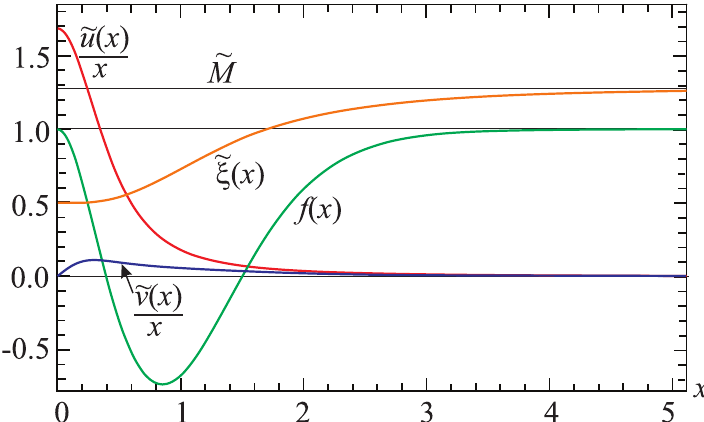
Figure 1. The graphs of the functions ˜ v ( x ) , ˜ u ( x ) , f ( x ) , and ˜ ξ ( x ) of the solution describing the spinball-plus-quantum-monopole system at ˜ λ = 0.1, ˜ Λ = 1/9, ˜ m q = 1, ˜ E = 0.8, m = 3, ˜ g = 1, ˜ ξ = 0.5, and f = − 20. The corresponding eigenvalues are ˜ µ ≈ 2.6727842881, ˜ M ≈ 1.2756, and 0 2 ˜ u 1 ≈ 1.68655.